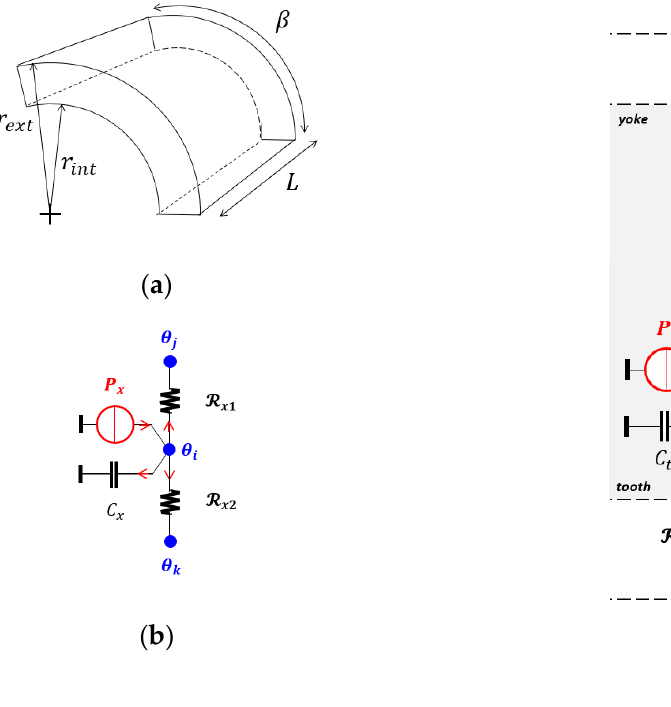
Figure 4. Cylindrical piece ( a ); with its thermal model ( b ); and thermal model of the whole machine ( c ).